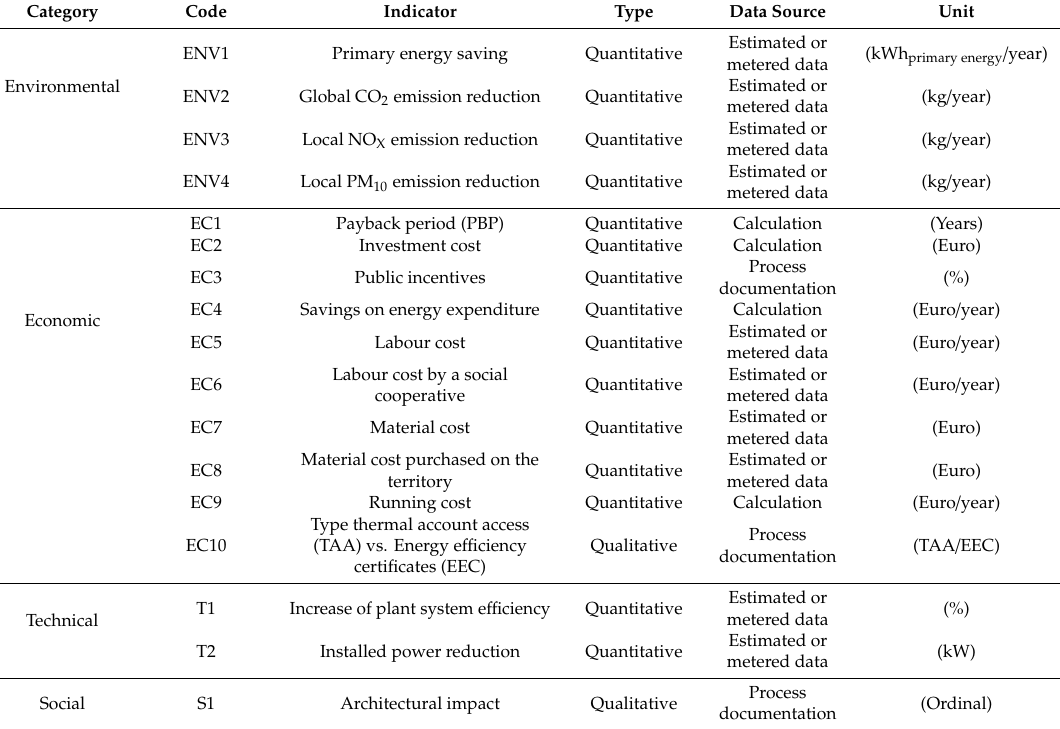
Table 10. Key performance indicator